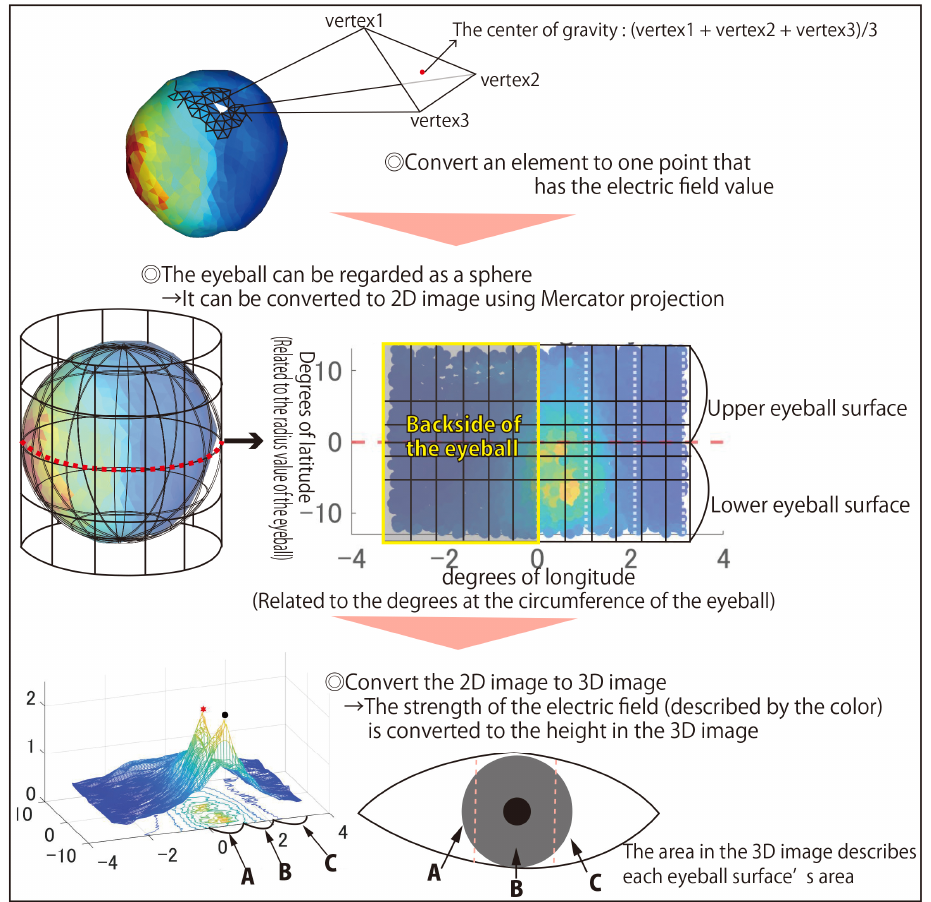
Figure 5. Evaluation methodology of the electric field simulation for showing the locality stimulation. The point with the maximum electric field value within the stimulation region is marked with a black circle, and the point with the maximum electric field value outside the stimulation region is marked by a red star. The area above the eyeball of the stimulation area is identified as “upper”, and the area adjacent to the stimulation area is identified as